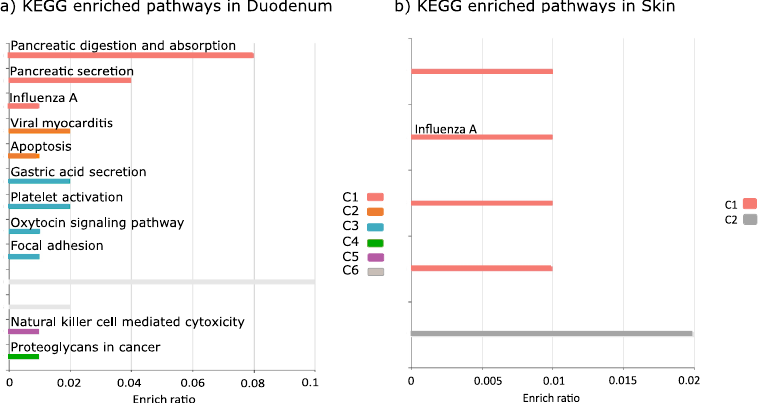
Figure 4. KEGG enriched pathways of LPS versus Sham DEGs. ( a ) duodenum, ( b ) skin. The enriched KEGG pathways that are closely related are grouped in the same cluster (C1 – C6) represented by the same color. Different clusters have a different color.